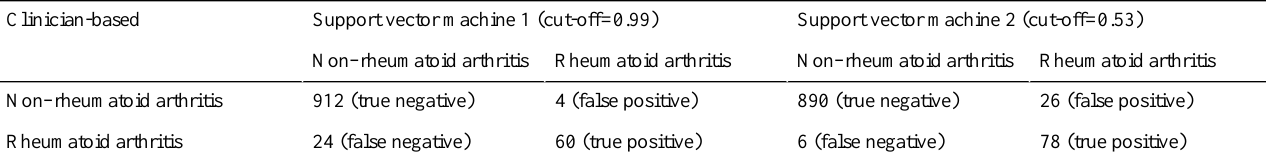
Table 1. Support vector machine confusion matrices for the Leiden-B test set (n=1000) .